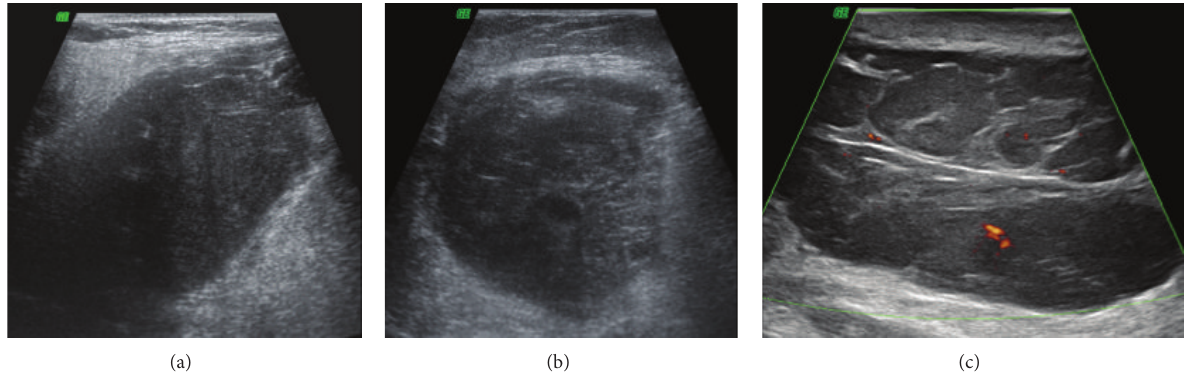
Figure 3: Small parts ultrasonography : cervical (a), popliteal (b), and abdominal wall (c) ultrasonography confirmed hypoechoic, well-defined masses in right submandibular gland topography, gastrocnemius muscle thickness, and the subcutaneous tissue, measuring 54 × 37 mm, 98 × 44 mm, and 73 × 47 mm,